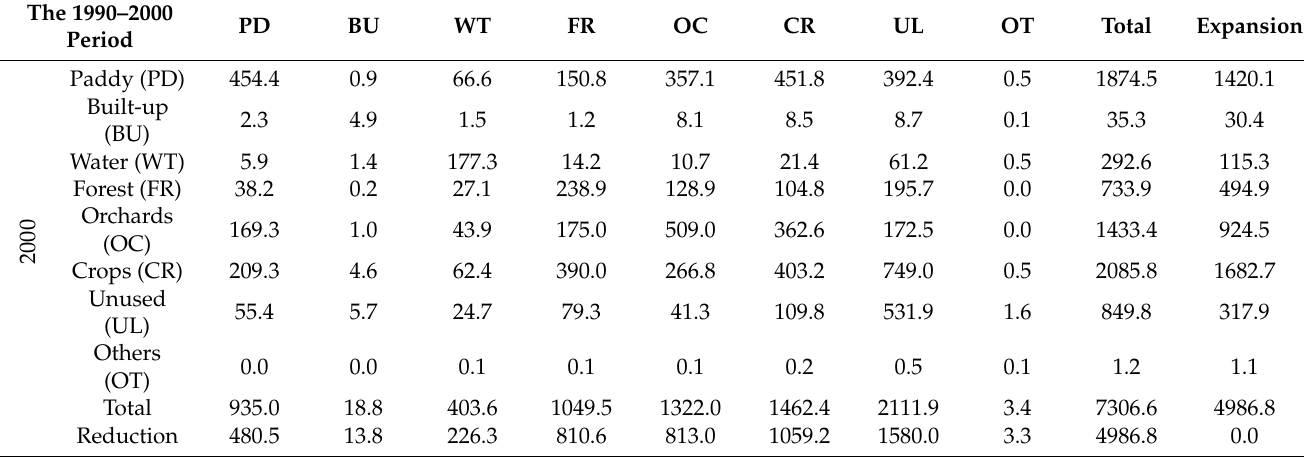
Figure 8. The magnitudes of change for the LULC classes in the Dong Thap Muoi, shown in ha/year, across different time spans. Table 7. LULC map changes for the Dong Thap Muoi area for the period 1990–2020 with detailed subperiods. Unit: km 2